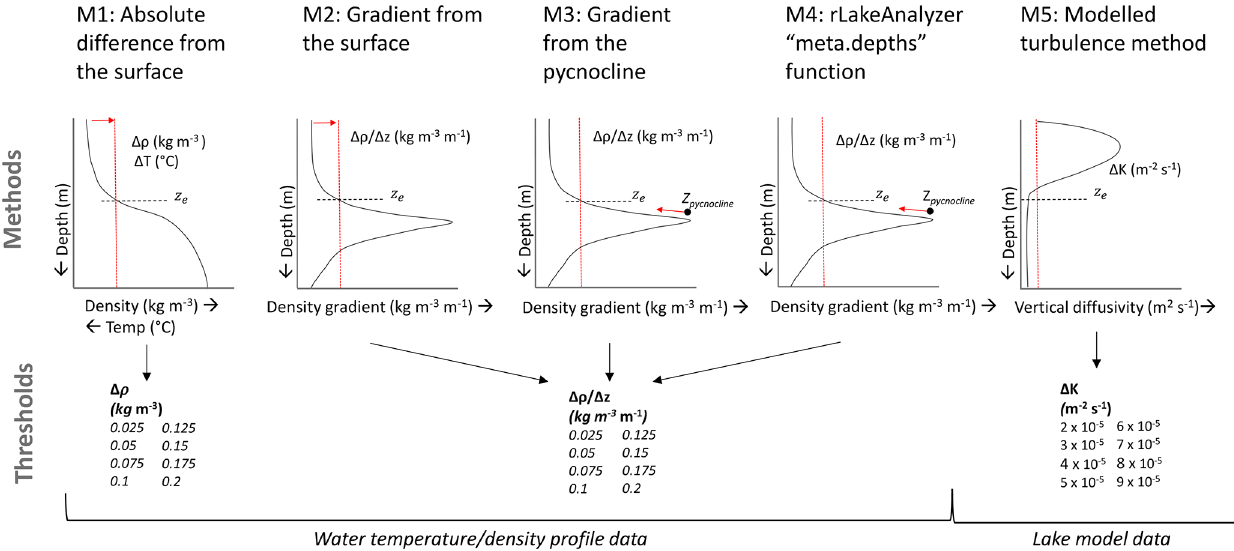
Figure 2. Schematic of epilimnion depth methods used in this study, including the range of threshold values for each method and the input data type (i.e. water temperature, density profile, or lake modelled